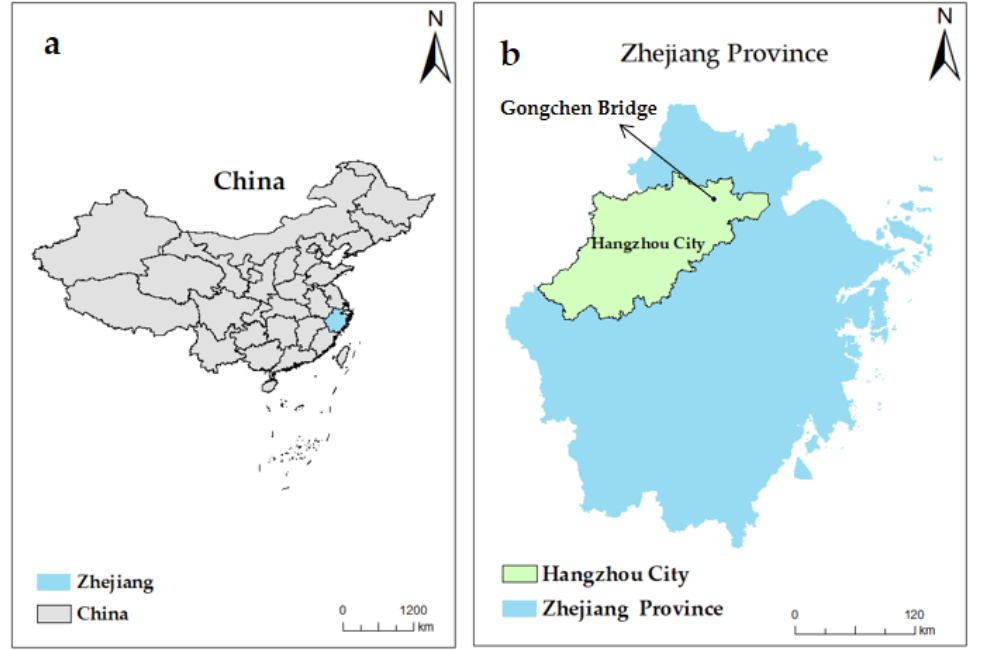
Figure 2. ( a ) The geographical location of Zhejiang Province in the People’s Republic of China; ( b ) the geographical location of the study site in Hangzhou, Zhejiang Province. Note: Gongchen Bridge, where the field survey was conducted, is an iconic scenic spot of the Grand Canal Scenic Area in Hangzhou.